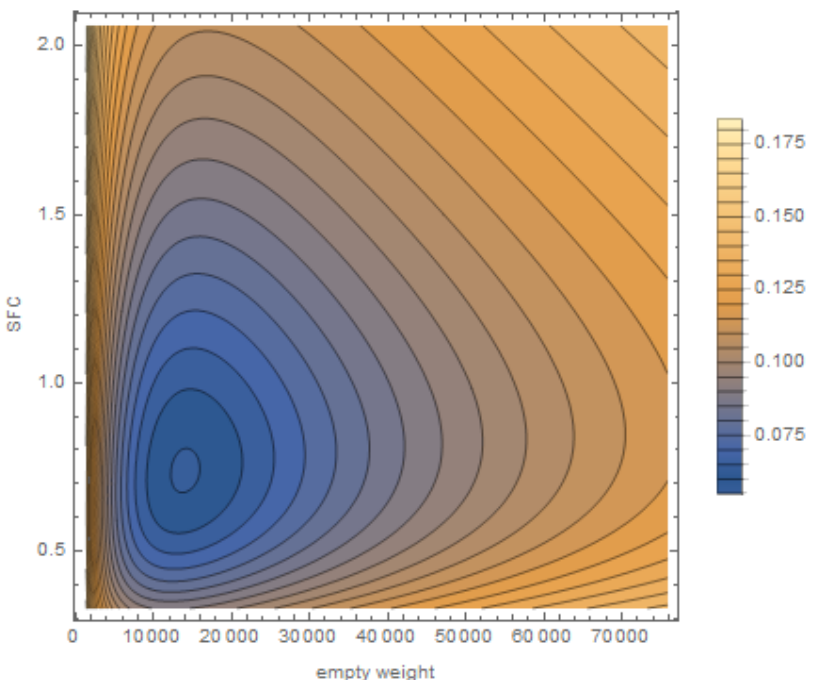
Figure 8. The standard deviation map for the construction of LogCPFH confidence intervals.